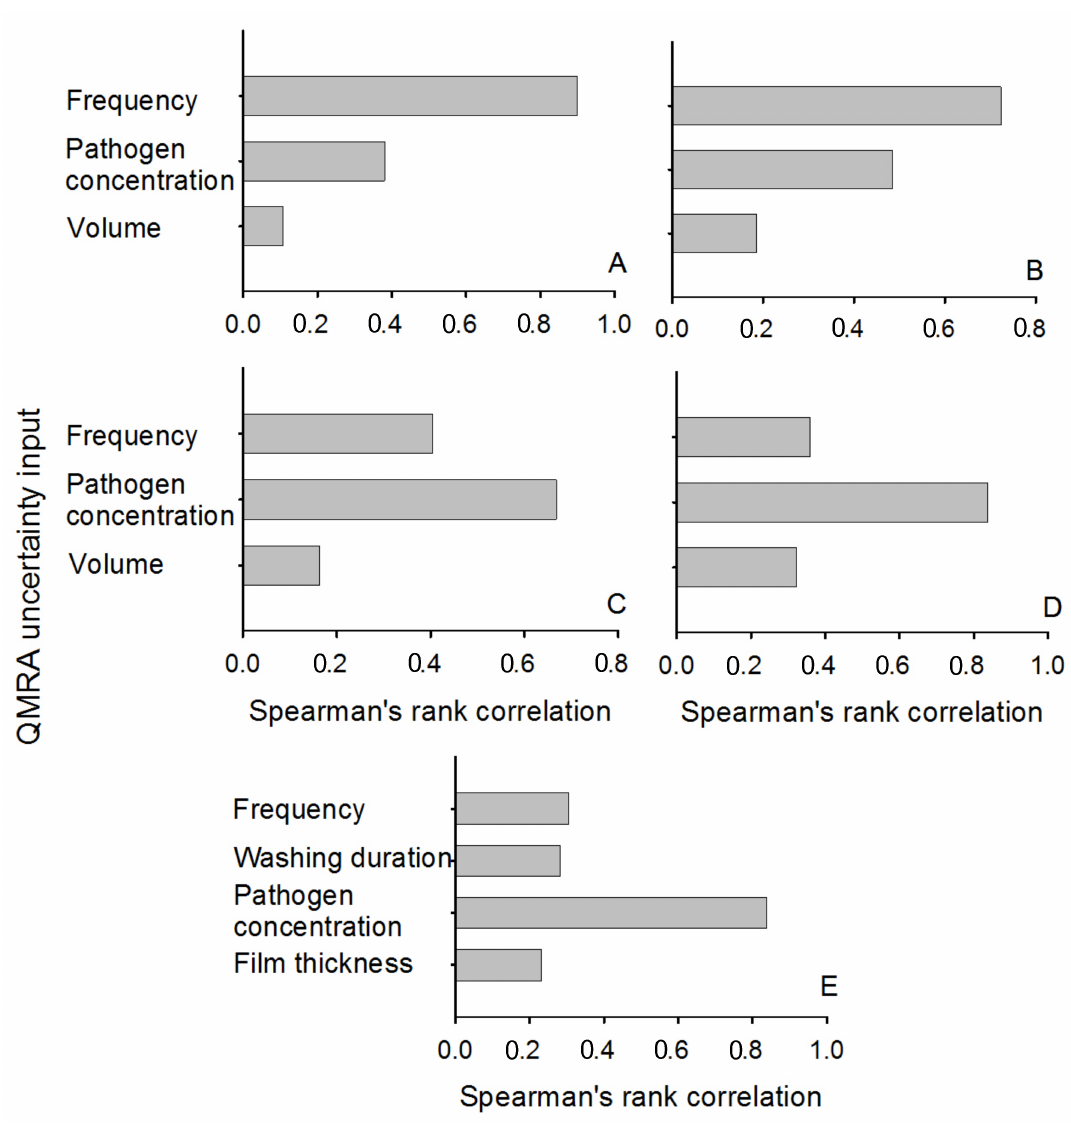
Figure 4. Uncertainty as determined by Spearman’s rank correlation for each worst-case scenario using Shigella spp. as the representative bacteria. ( A ) Scenario (i)—accidental ingestion (drinking); ( B ) Scenario (ii)—aerosol exposure; ( C ) Scenario (iii)—garden work; ( D ) Scenario (iv)—crop consumption; and ( E ) Scenario